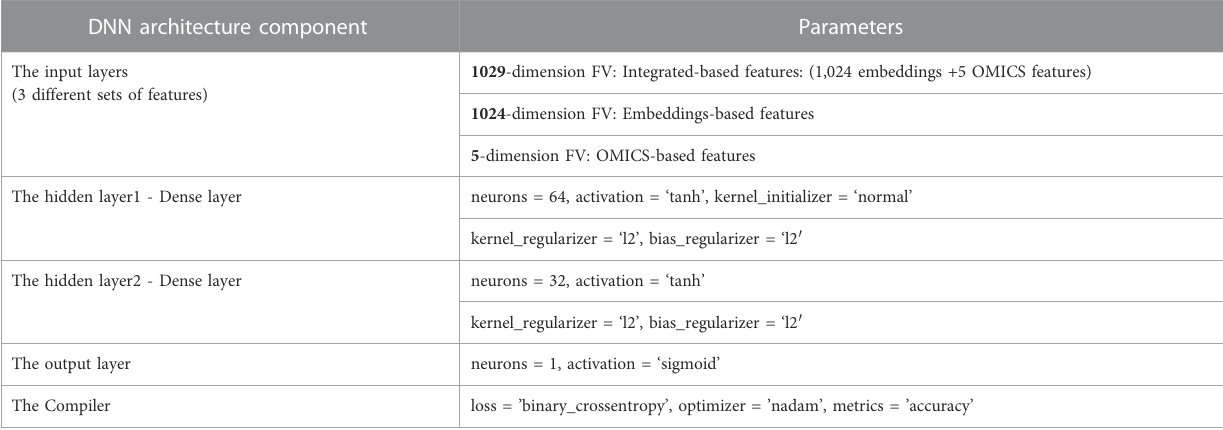
TABLE 4 The proposed DNN model ’ s architecture with each layer ’ s parameters. DNN architecture component